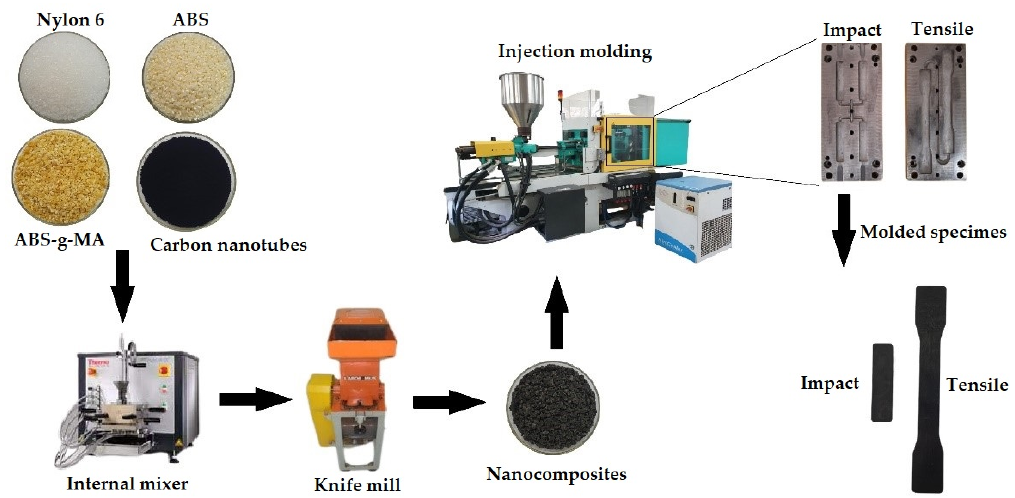
Figure 13. Representation of nanocomposite preparation.